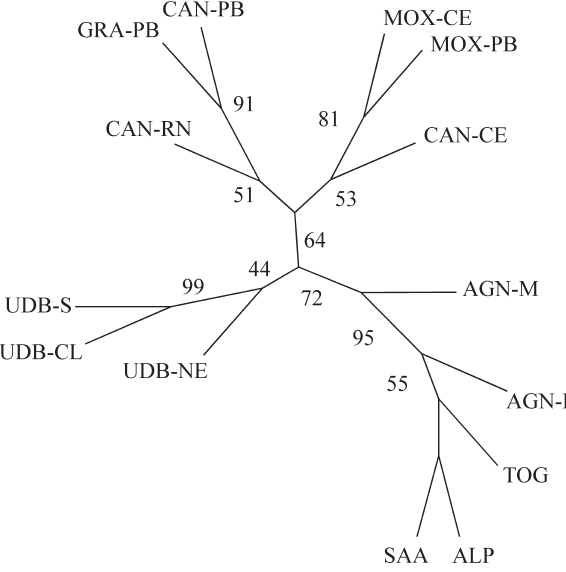
Figure 2 - Phenogram showing the relashionship among 14 Brazilian goat populations using genetic distance of Reynolds based on 13 microsate- llites loci and Neighbor-Joining method (Saitou and Nei, 1987). Numbers at nodes are the percentages of 1,000 bootstrap replicates in which these Figure 1 - Plot of scores of principal component analysis based on allele nodes appeared. This is an unrooted tree. 1: Moxotó Ceará (MOX-C); 2: frequency of 14 populations of goats. 1: Moxotó Ceará (MOX-C); 2: Moxotó Paraíba (MOX-PB); 3: Canindé Ceará (CAN-CE); 4: Canindé MoxotóParaíba(MOX-PB);3:CanindéCeará(CAN-CE);4:CanindéRio Rio Grande do Norte (CAN-RN); 5: Canindé Paraíba (CAN-PB); 6: Grande do Norte (CAN-RN); 5: Canindé Paraíba (CAN-PB); 6: Graúna Graúna Paraíba (GRA-PB); 7: In absorbent crossing with Anglo-Nubian Paraíba (GRA-PB); 7: In absorbent crossing with Anglo-Nubian purebred purebred (AGN-M); 8: Alpine and German Alpine (ALP); 9: Anglo- (AGN-M); 8: Alpine and German Alpine (ALP); 9: Anglo-Nubian Nubian (AGN-P); 10: Toggenbourg (TOG); 11: Saanen (SAA): 12: north- (AGN-P); 10: Toggenbourg (TOG); 11: Saanen (SAA): 12: northeastern eastern undefined breed (UDB-NE); 13: middle-eastern undefined breed undefined breed (UDB-NE); 13: middle-eastern undefined breed (UDB-CL); 14: southern undefined breed (UDB-CL); 14: southern undefined breed (UDB-S). Table 3 - Estimates of F IS and F ST calculated by method of Weir and Cockerham (1984) based on allelic frequency of 14 goat populations, using the GDA program. Locus Only UDB Only native F IS F IS